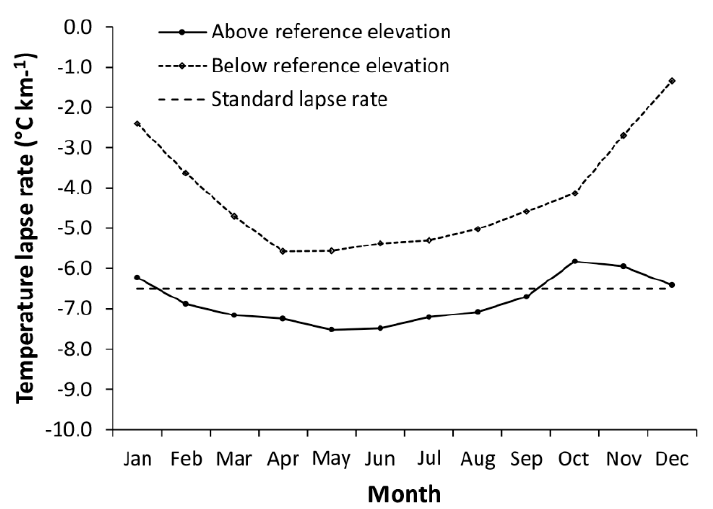
Figure 4. Mean monthly temperature lapse rates applied above/below the reference elevation (Peio weather station, 1586 m) for thermal inversions.